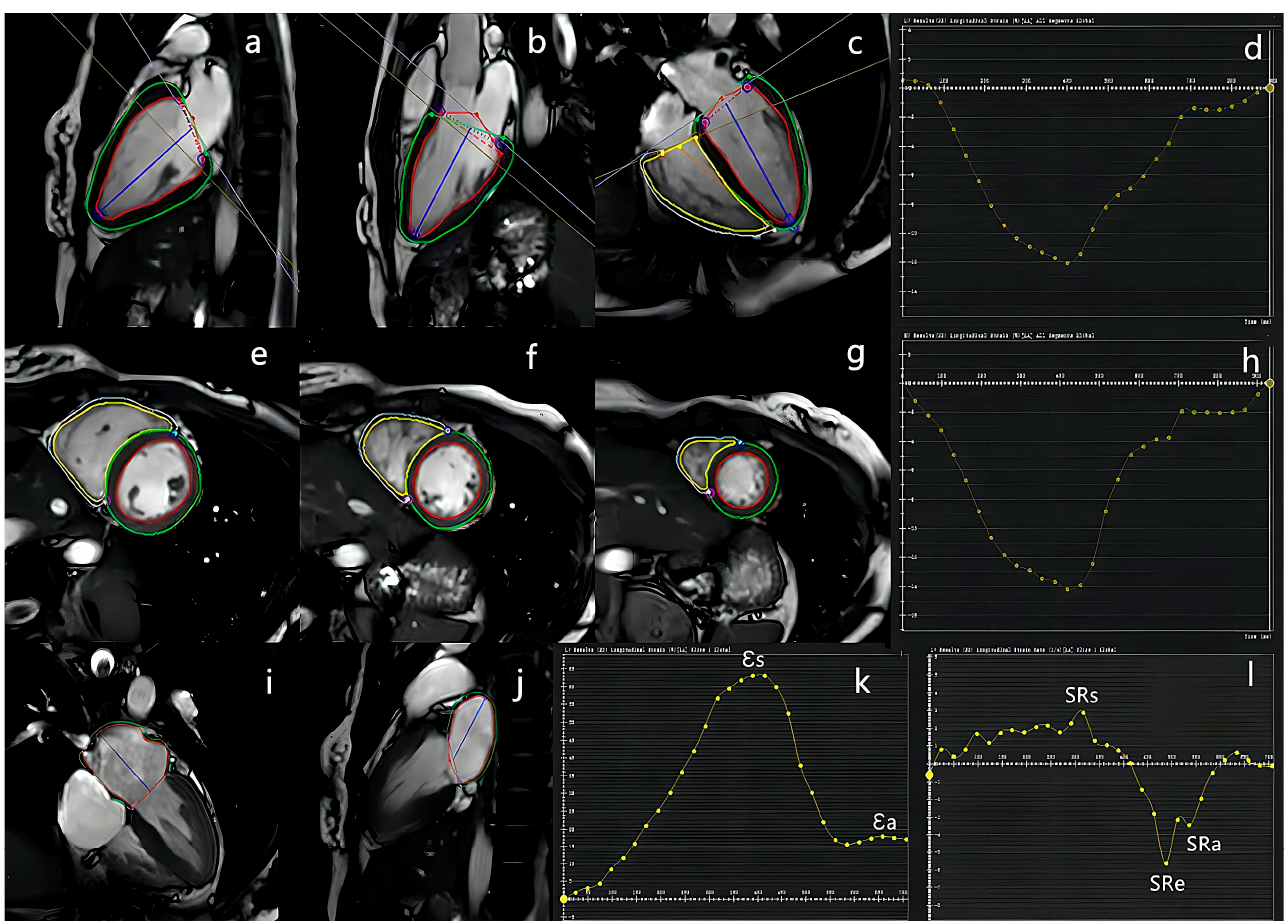
Figure 1. Representative example of left atrial and biventricular strain analysis. 2-, 3-, and 4-chamber view long-axis ( a – c ) and short-axis (( e – g ), from bottom to apex) cine images were used for ventricular strain analysis. The endo- and epicardial borders of both ventricles were depicted, red and green lines in picture ( a – c,e – g ) refer to LV endo- and epicardial borders, respectively; yellow and blue lines in picture ( c , e – g ) refer to RV endo- and epicardial borders, respectively; and the curves of peak global longitudinal of LV ( d ) and RV ( h ) were automatically constructed. 2- and 4-chamber view long-axis ( i,j ) cine images were used for left atrial strain analysis. The endo- (red lines) and epicardial (green lines) borders of the LA were manually depicted, and the curves of peak strain ( k ) and strain rate ( l ) of the LA were automatically constructed.